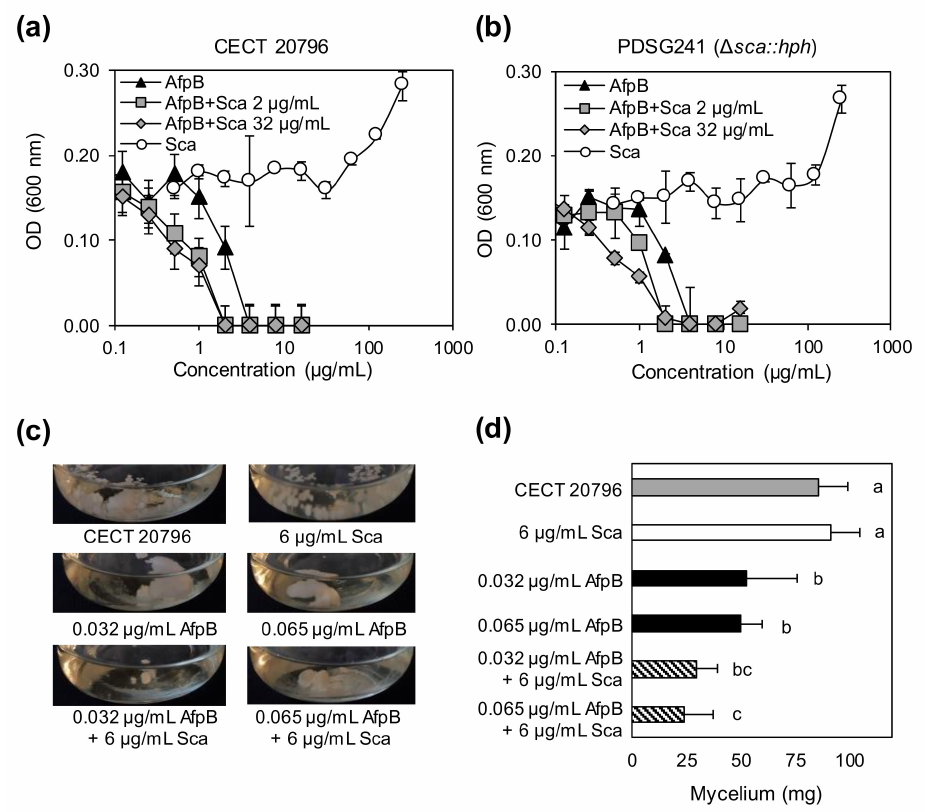
Figure 4. In vitro antifungal assays of the Sca / AfpB proteins against P. digitatum . ( a ) Dose–response curves showing in vitro antifungal activity of AfpB and Sca proteins against P. digitatum CECT 20796. Note the absence of antifungal activity in Sca and improvement of antifungal activity of AfpB due to addition of the Sca protein at di ff erent concentrations. ( b ) Dose–response curves showing in vitro antifungal activity of AfpB and Sca proteins against P. digitatum PDSG241 ∆ sca strain. Similar details as in ( a ). ( c ) Representative images of growth inhibition assays in flasks containing different amounts of proteins and protein combinations as indicated. ( d ) Graph representing the weight of collected mycelia from ( c ). Bars show means ± standard deviation (SD) of biological triplicates. Letters show significant differences among the treatments (ANOVA and Tukey’s honestly significant difference (HSD) test, p <